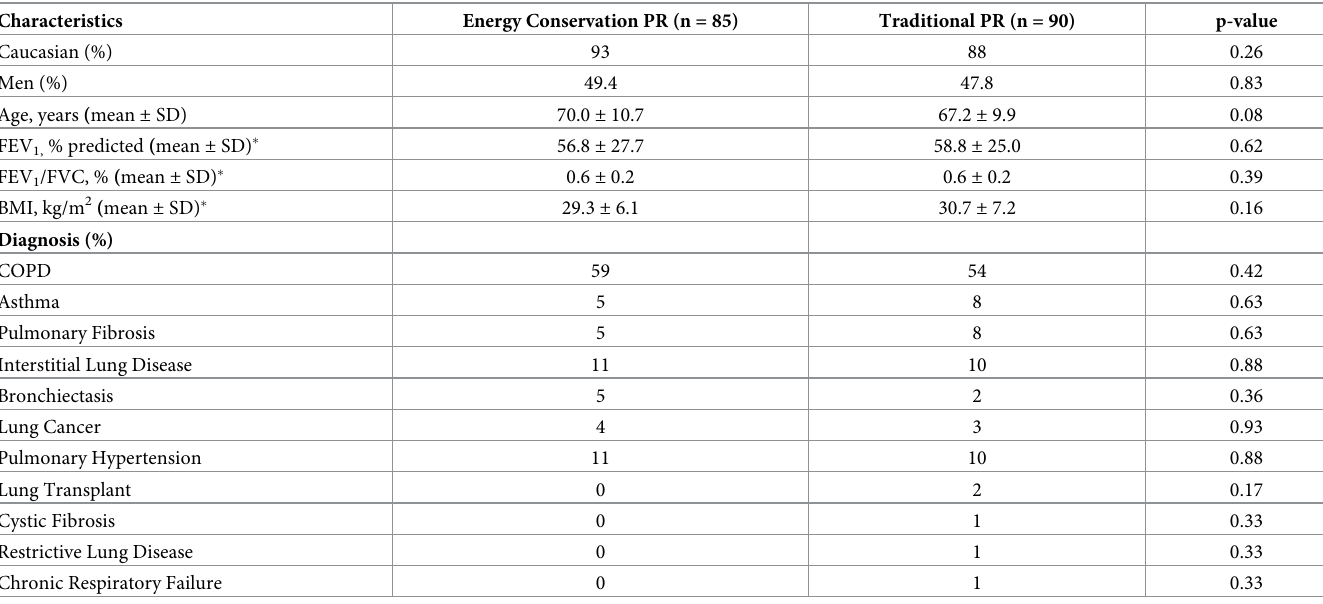
Table 1. Baseline characteristics. Characteristics